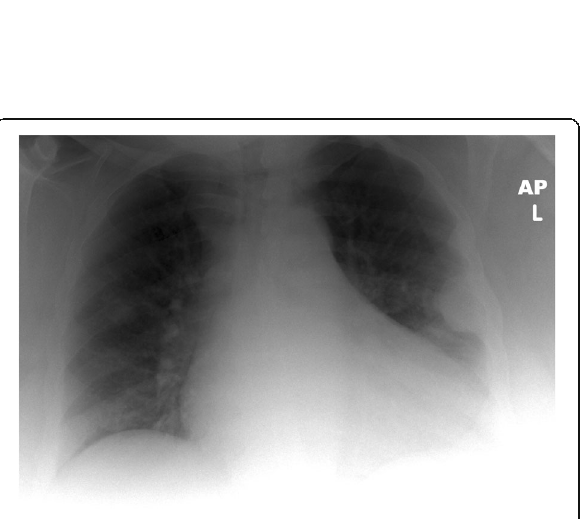
Fig. 7 CT of the patient showed a well-corticated lucent lesion with patchy high density areas in the rest of the pelvic bone in keeping with previous rickets